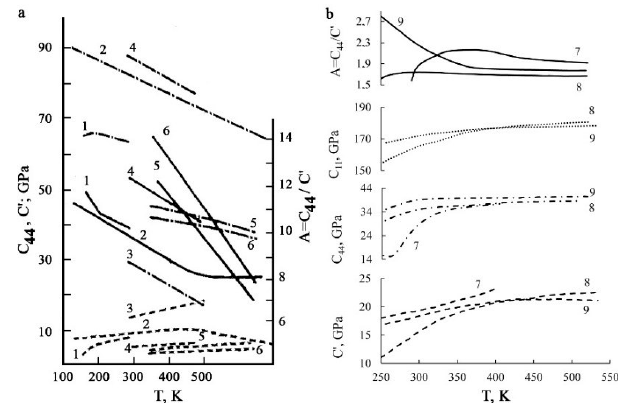
Figure 4. Temperature–concentration dependences of single-crystalline elastic constants C 11 (dot line), C’ (dotted line), C 44 (dash-dotted line) and the parameter of the elastic anisotropy A = C 44 /C’ (solid line); ( a ) BCC alloys: 1—Au-Zn-Cu, 2—Cu-Zn, 3—NiAl, 4—Cu-Al-Zn, 5—Au-50 at. % Cd and 6—Au- 47.5 at. % Cd [19] and ( b ) 7—Ti 49 Ni 51 , 8—Ti 50 Ni 48 Fe 2 and 9—Ti 50 Ni 38 Cu 10 Fe 2 [12,13] (Copyright, 1987, Izvestia VUZov).